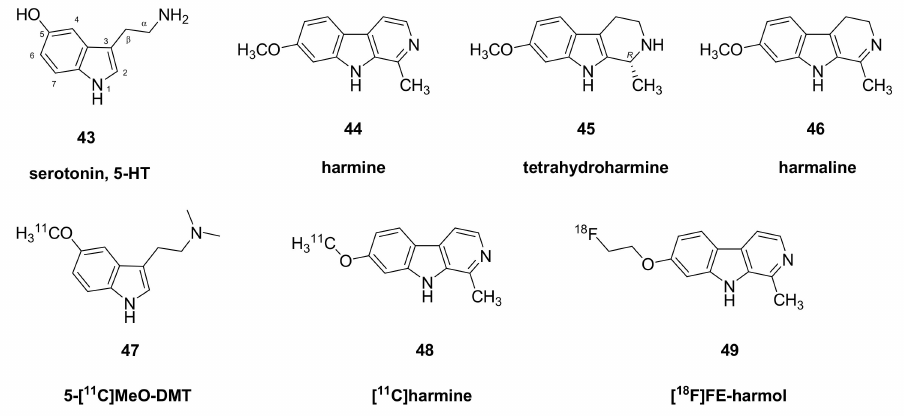
Figure 5. Structures of serotonin and some indole